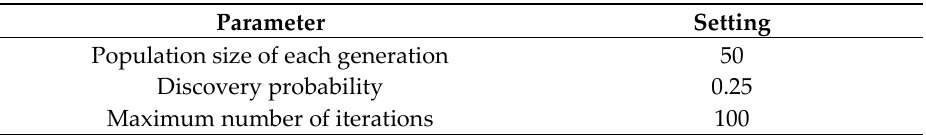
Table 2. Parameter settings of the cuckoo search algorithm used for the identification of resistance